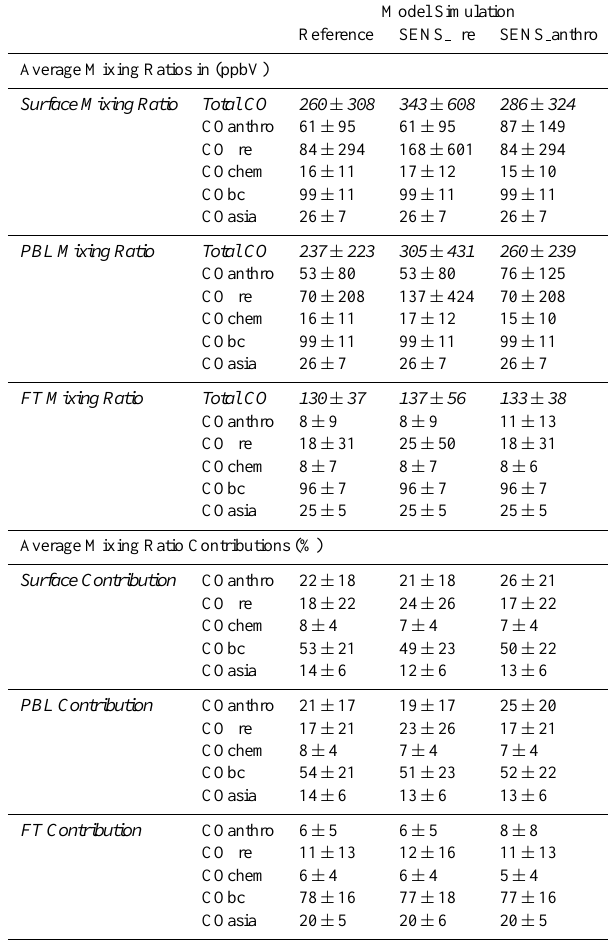
Table 2. Source contribution statistics for the three different WRF- Chem